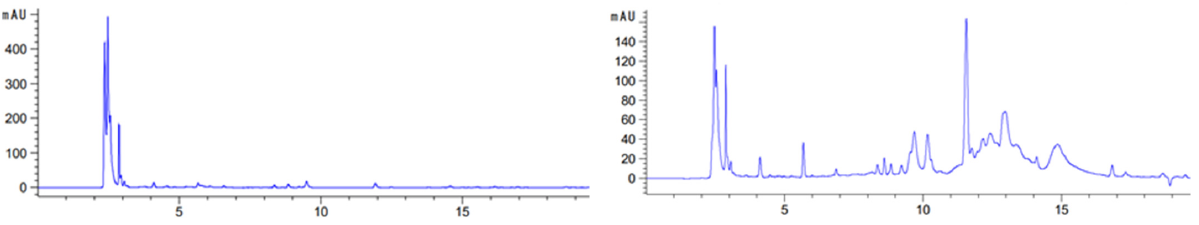
Figure 6. Sm salami meat ( left ); Sv salami vegetarian ( right ). Vegetable oils are used in analogue meat as a replacement for animal fat. Proteins and fats of meat analogues undergo intensive processing; therefore, antioxidants are added in order to prevent fat rancidity and protein oxidation [38,39]. Several spices and aromatic plants are used in the production of meat and meat analogues to improve their antioxidant activity (as well as flavour and antimicrobial) properties. The most common such spices and aromatic plants are oregano, parsley, rosemary, dill, basil, marjoram, sage, coriander, thyme, tarragon, bay, and mint [40]. 3.2. Sensory Analysis Results of the sensory analysis are shown in Tables 3 and 4. There was no significant difference between the meat products and their analogue products ( p > 0.05). This result includes the mutual visual inseparability of the meats and their analogue products. For all meat products and their analogues, there were no significant differences in the texture ( p > 0.05), except for the Hungarian sausage and its analogue ( p < 0.05). Generally, meat analogues should resemble meat products in their textural properties in order to be ac- cepted by consumers [41]. Meat analogues are designed to match the organoleptic prop- erties (such as the color, texture, flavour, and sensation in the mouth) of real meat as far as possible in order to constitute desirable and acceptable products for consumers [42].